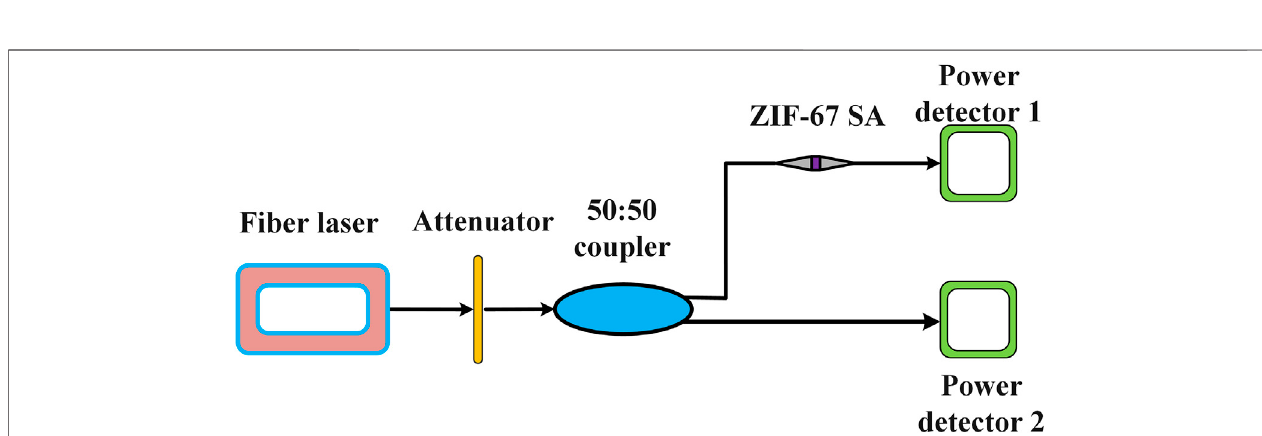
FIGURE 2 | The setup for determining the nonlinear optical absorption characteristics of the ZIF-67 SAs.